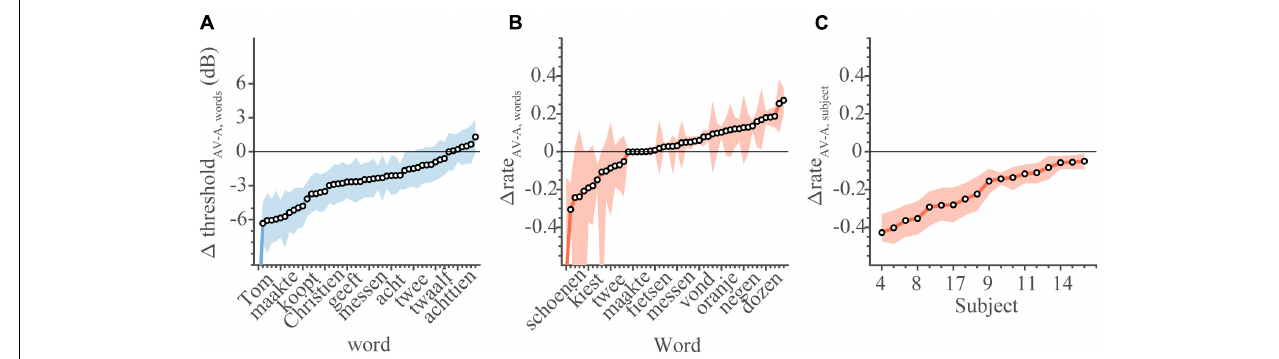
FIGURE 5 | Comparison between audiovisual and unimodal conditions. Change in threshold and rates of AV speech recognition in comparison to unimodal listening conditions. (A) The change in threshold for each word (equation 4). Note that a negative change in threshold denotes better performance in AV conditions. (B) The change in recognition rate for each word (equation 5). (C) The change in recognition rate for each subject. For rates, a change larger than 0 denotes better AV performance. Open circles denote the mean of the parameter estimate, colored patches indicate 95%